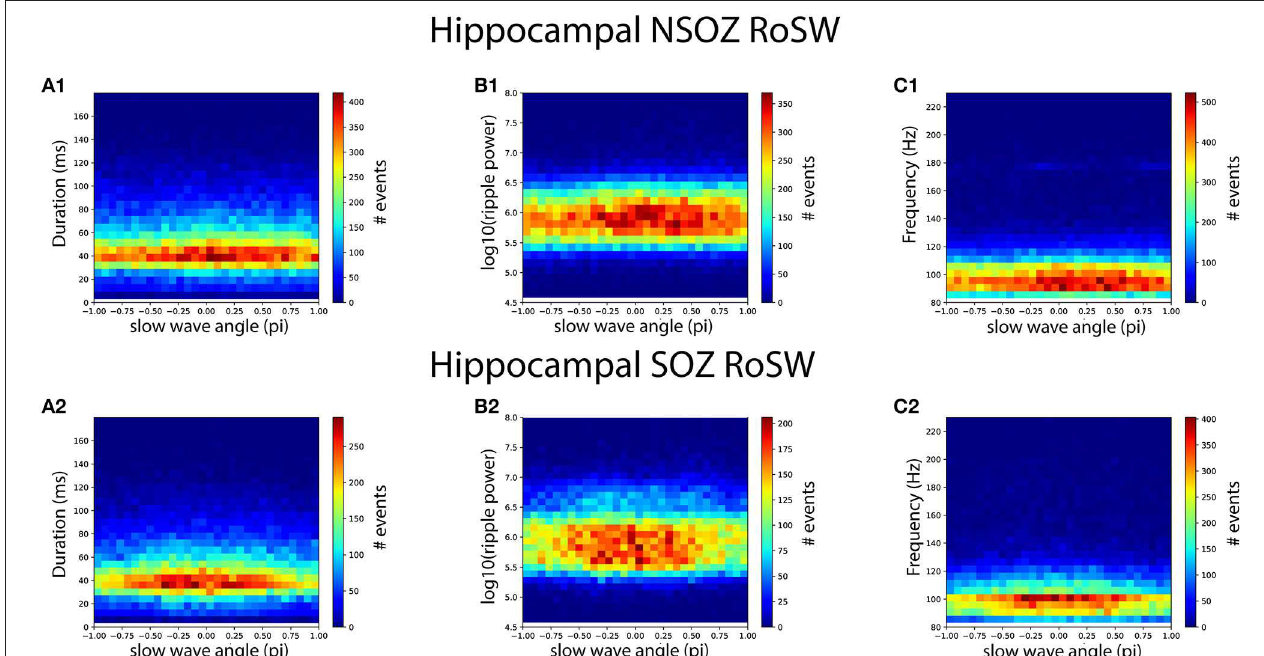
FIGURE 2 | Longer duration, higher power, lower spectral content ripples on slow waves (RoSW) during the peak-trough transition were more frequent in the hippocampal non-seizure onset zone (NSOZ) than the SOZ. Histograms quantifying the number of RoSW events binned by (A1,A2) duration, (B1,B2) spectral power, and (C1,C2) spectral frequency and by the phase angle of coupling recorded from the NSOZ (top row) and the SOZ (bottom row).